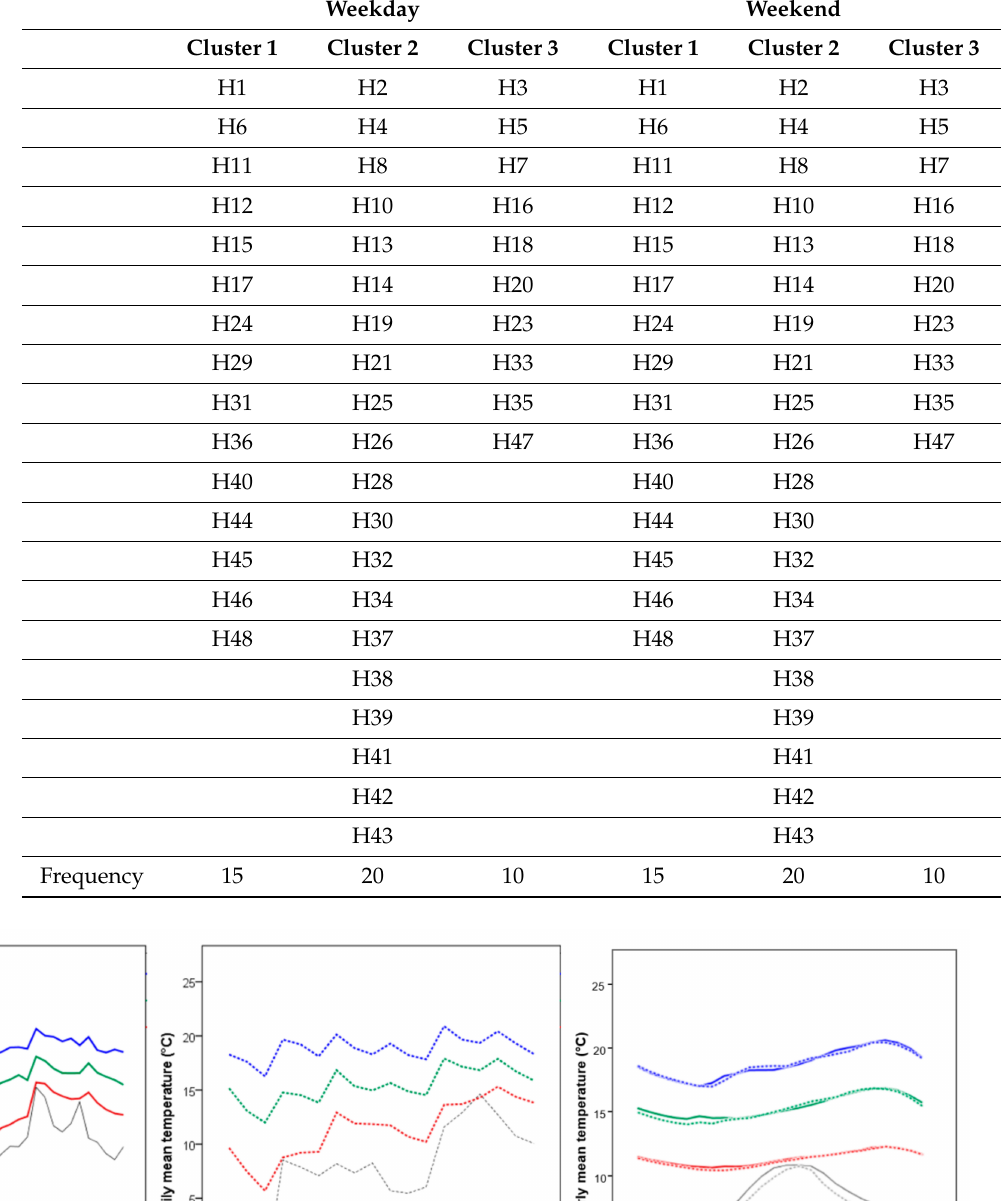
Table 9. Clusters’ membership of the cases for weekdays and weekends in winter.